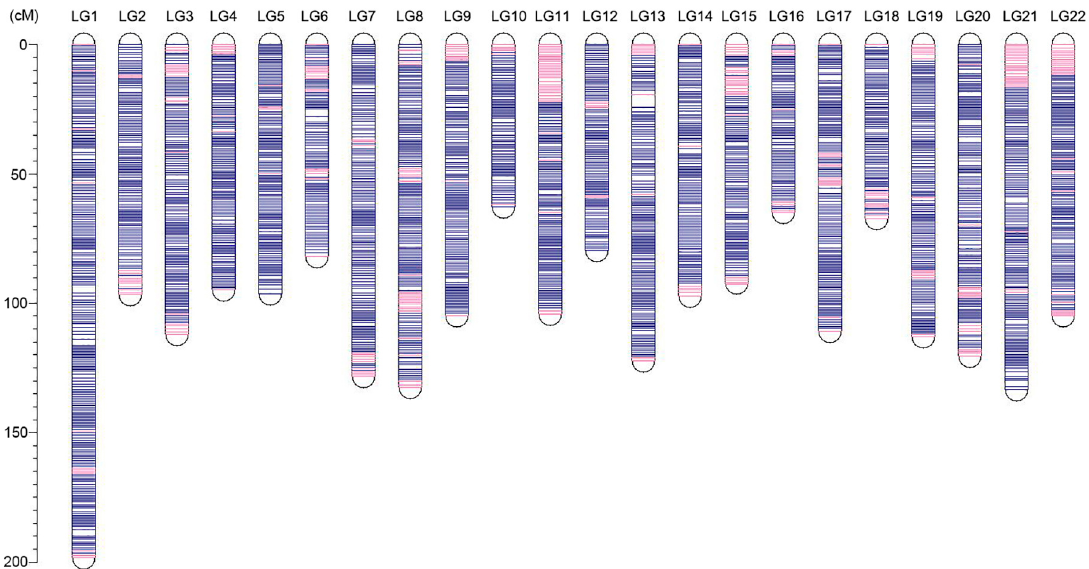
Figure 3. Ideograms of the genetic linkage map of torafugu. The genetic position of each SSG is illustrated in each linkage group. SSGs are indicated as a blue line if the sequences could be aligned to the published genome FUGU5 using BLASTN (version 2.2.29), and are otherwise shown as a pink line. LG: linkage group; the y-axis represents the genetic position (cM). Table 1. Summary of the genetic linkage map of torafugu.